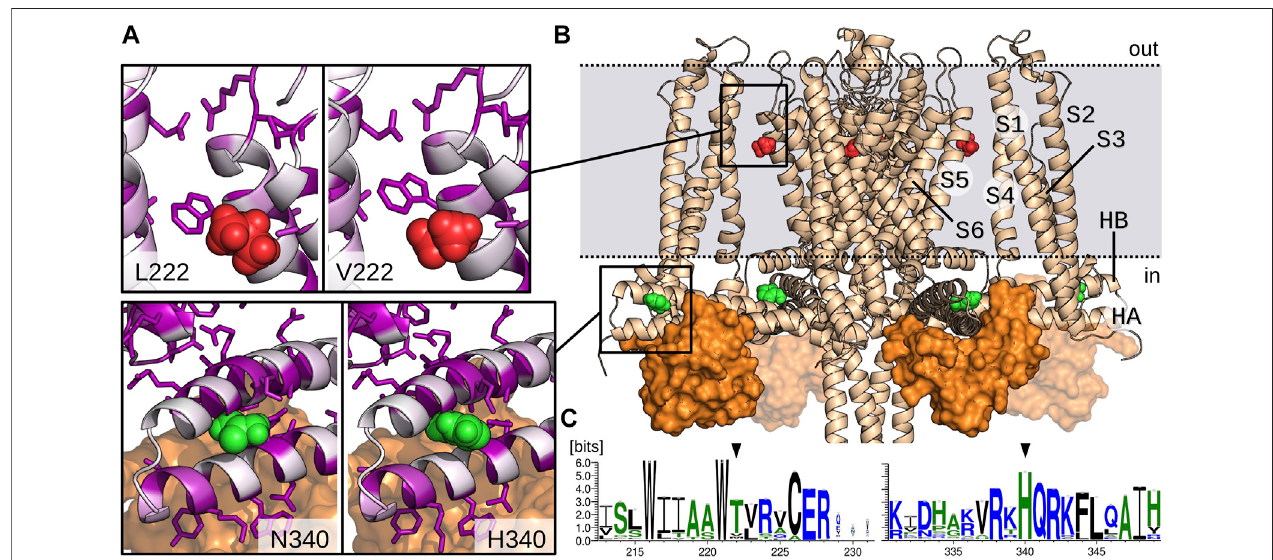
FIGURE 5 | Model of KCNN4 showing V222 and H340 amino acids location. (A) Zoom on V222 (red) and H340 (green) environment in the activated/closed KCNN4/CaMmodel.Mutantmodels(L222andN340)arepresentedintheleftwindows.KCNN4residuesarecoloredaccordingtotheirconservationfrequency(whiteto purple) in the multiple sequence alignment. Side chains of residues with a conservation percentage greater than 70% are represented. (B) Model of KCNN4/CaM complex based on cryo-EM structures. For clarity, only KCNN4 and C-lobes (orange surface) of the four CaM molecules are shown. Dashed lines delineate the position of plasma membrane upper and lower lea fl ets. (C) Weblogos of the KCNN4 sequence segments encompassing positions 222 and 340 (black